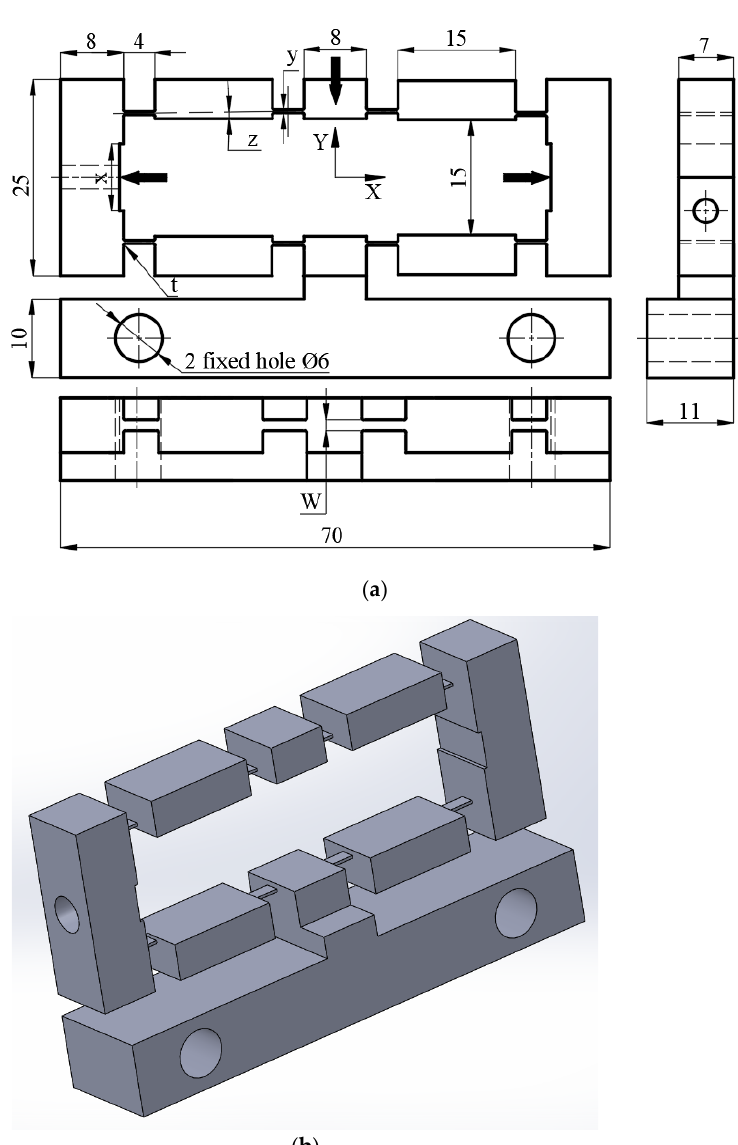
Figure 1. Developed compliant mechanism model of bridge-type: ( a ) 2D drawings, and ( b ) 3D drawing.